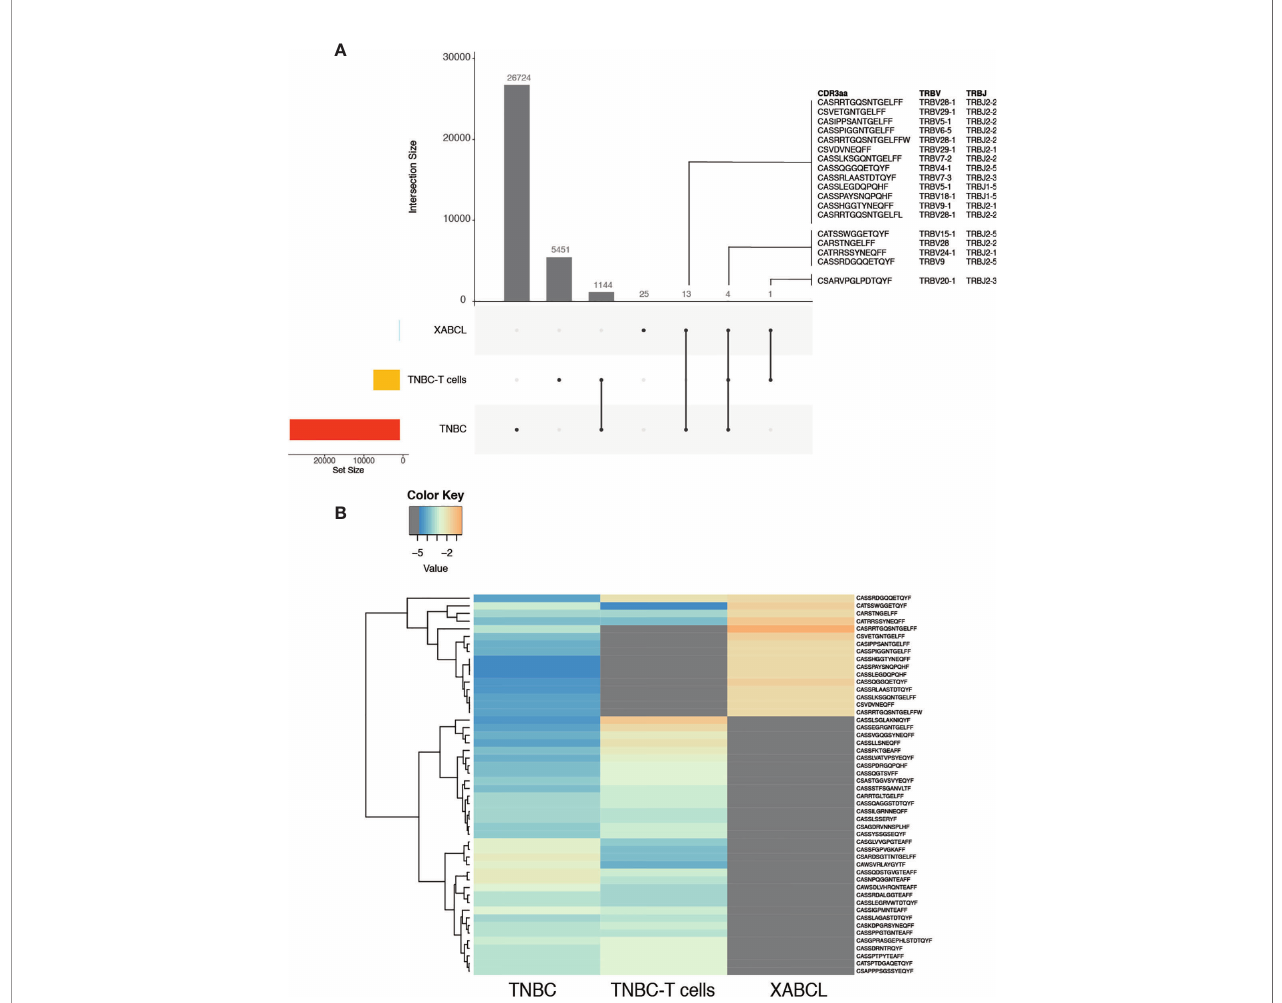
FIGURE 3 | Some T-cell receptor (TCR) sequences from the XABCL tissue were present in the TNBC tissue and the TNBC-T cells, but the three samples presented different TCR repertoire patterns. (A) UpSet plots represent the number of shared TCR sequences between samples. Eighteen TCR sequences were found in the XABCL and the TNBC biopsy and/or the TNBC-T cells. Twenty- fi ve sequences were exclusively found in the XABCL. (B) The heat plot of the 50 most abundant clonotypes in the shared samples revealed a global different pattern of the TCR repertoire in fi ltrating the